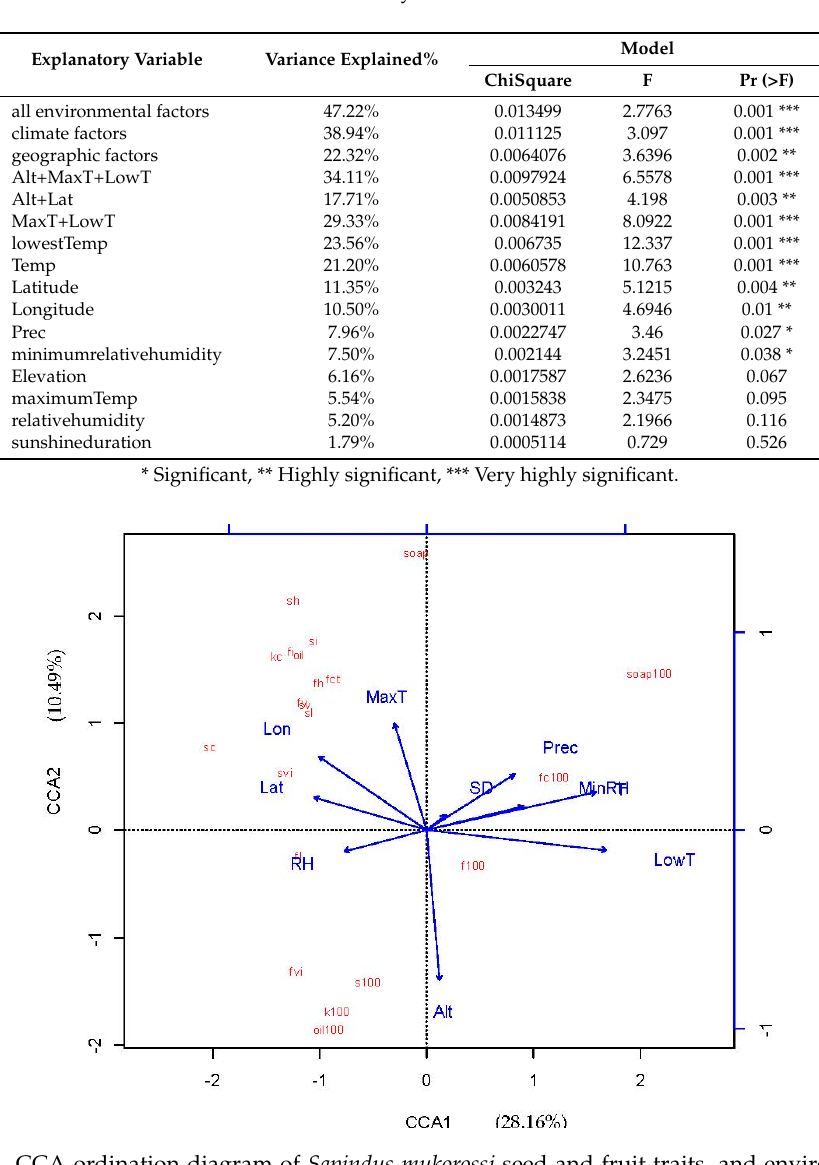
Figure 3. Simplified CCA ordination diagram of Sapindus mukorossi seed and fruit traits, and environmental factors.